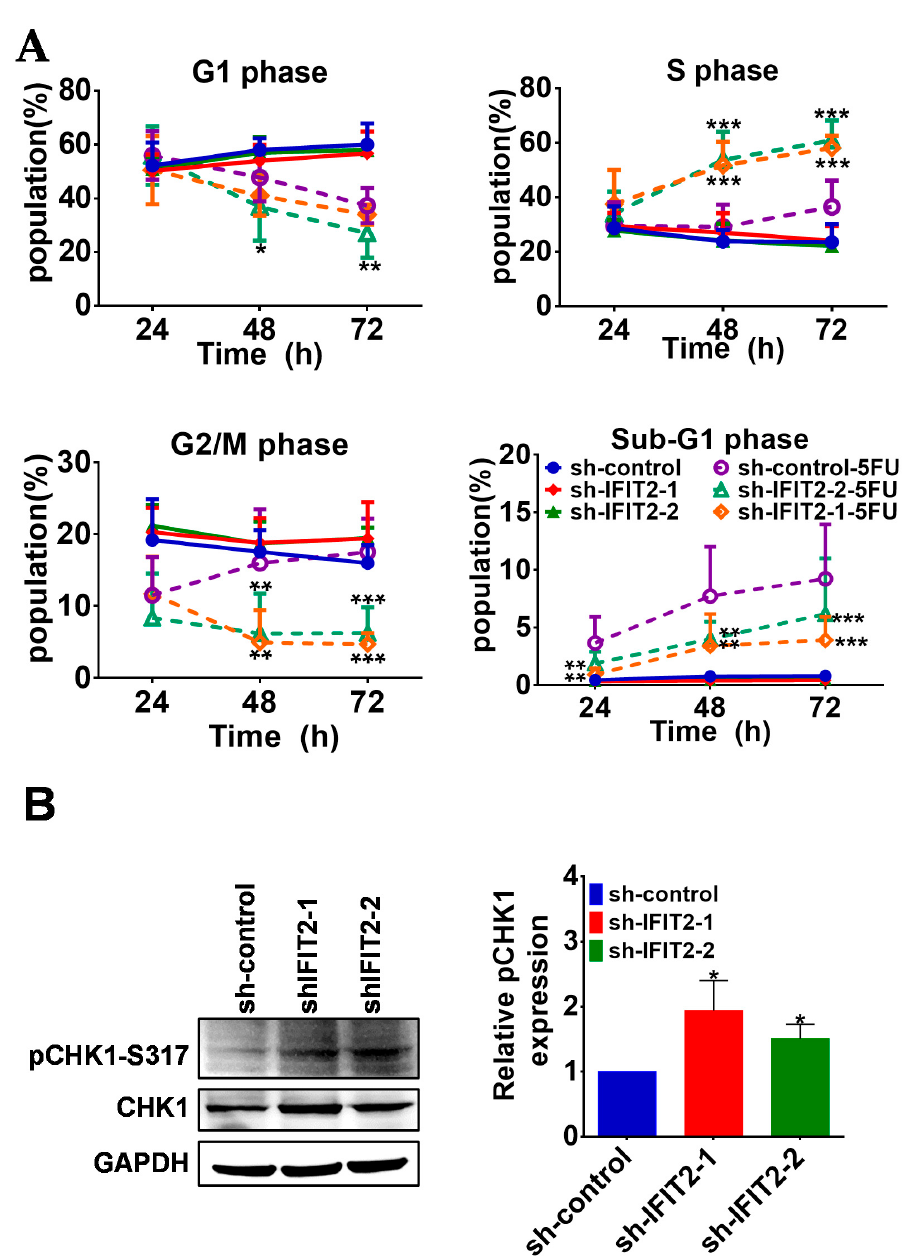
Figure 2. Cell cycle interference by 5-FU. ( A ) Cell cycle analysis. Growing sh-control, sh-IFIT2-1 and sh-IFIT2-2 cells were treated with 10 µ M 5-FU for 24, 48 and 72 h. The cells were harvested, and the cell cycle phase was analyzed by flow cytometry as described in the Materials and Methods. The symbols *, ** and *** denote statistically significant di ff erences compared to sh-control at p < 0.05, p < 0.01 and p < 0.001, respectively. ( B ) Increased basal levels of pChk1-S317 in IFIT2-knockdown cells. The lysates of sh-control, sh-IFIT2-1 and sh-IFIT2-2 cells were subjected to Western blot analysis using antibodies against Chk1 and pChK1-S317, respectively. The bar values in the right panel is the quantitative SEM values of relative expression of pCHK1.